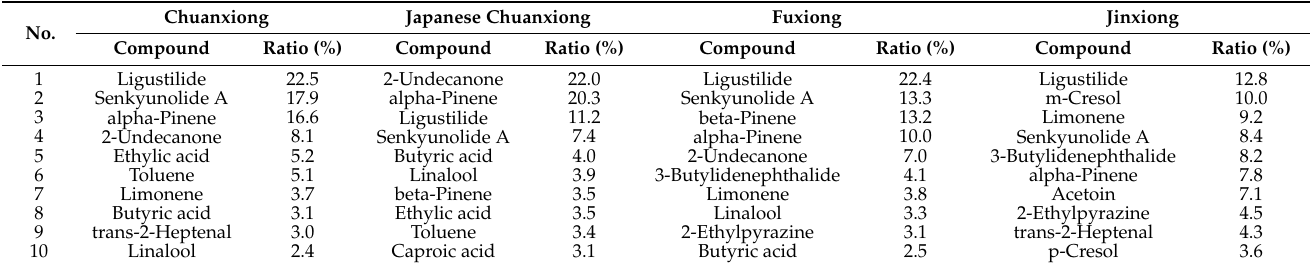
Table 3. The top ten compounds in the detected volatile compositions of the four herbs.